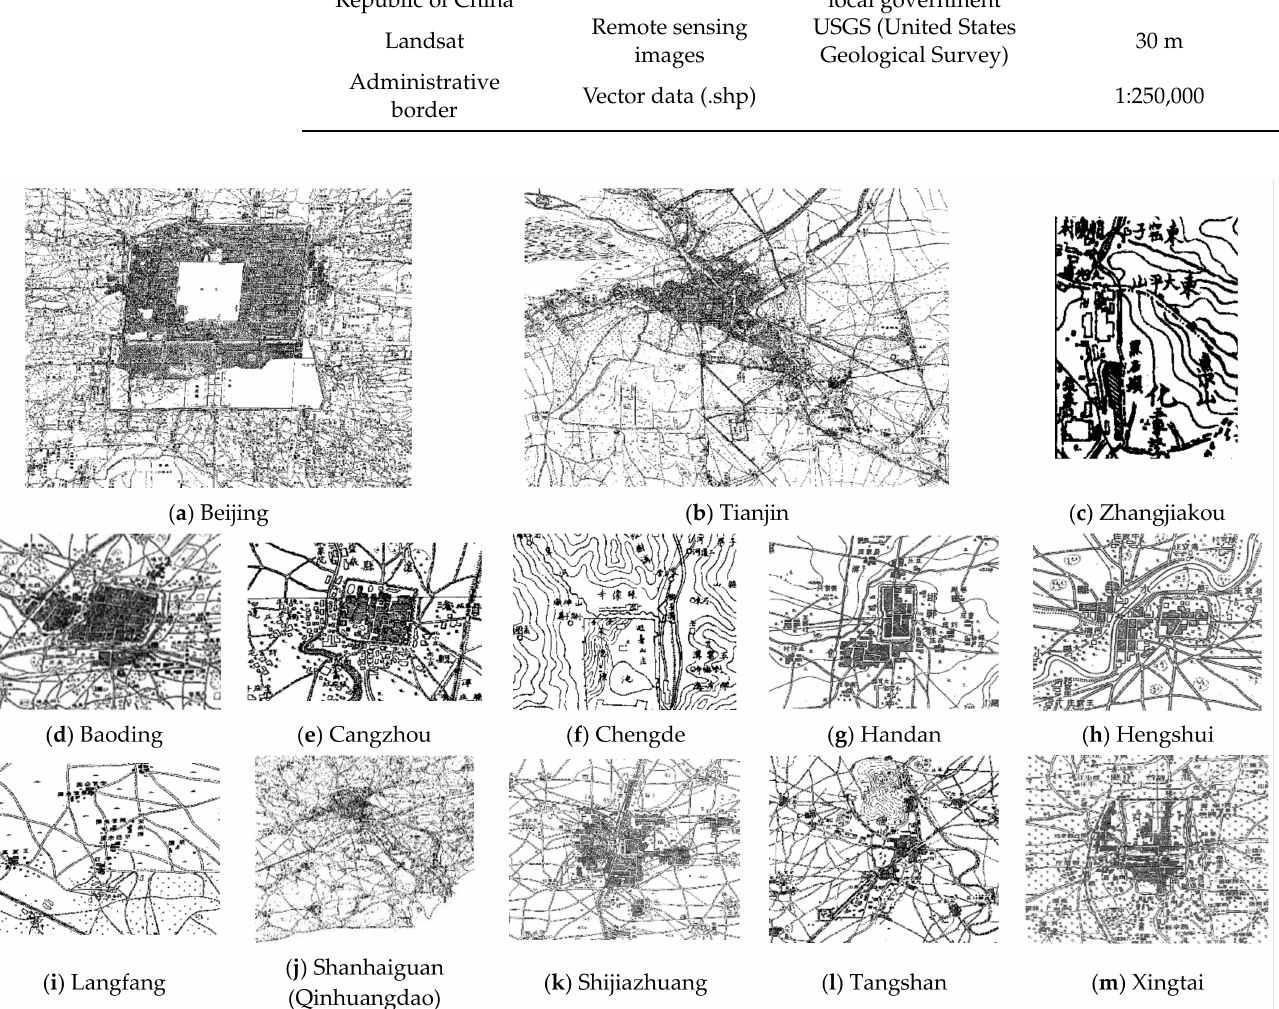
Figure 3. Systematic illustration of the BTH military topographic maps (1: 50,000 or 1: 100,000) in the Republic of China. ( a ) Beijing; ( b ) Tianjin; ( c ) Zhangjiakou; ( d ) Baoding; ( e ) Cangzhou; ( f ) Chengde; ( g ) Handan; ( h ) Hengshui; ( i ) Langfang; ( j ) Qinhuangdao; ( k ) Shijiazhuang; ( l ) Tangshan; ( m )